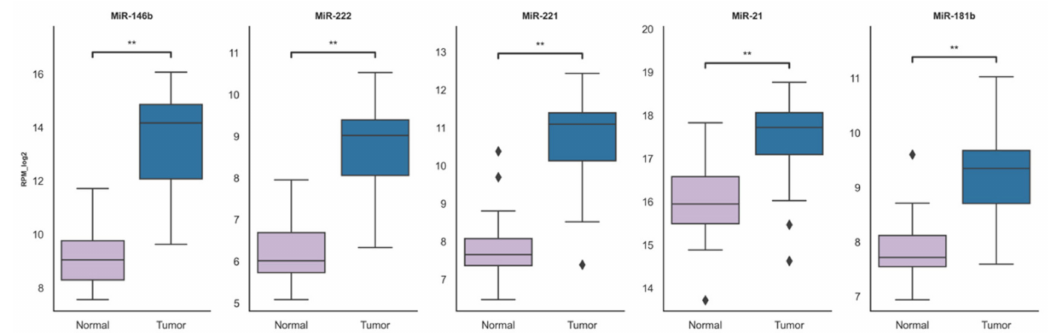
Figure 3. The comparison of miRNA expression between tumor and normal tissue adjacent to the tumor (normal) groups. The box squares represent the data within 25 and 75 percentiles, the line in the middle shows the median, the outliers are shown as diamonds. ** p < 0.0001. A total of 31 patients were analyzed (paired tumor and adjacent to the tumor (normal) 31 cases in each group).